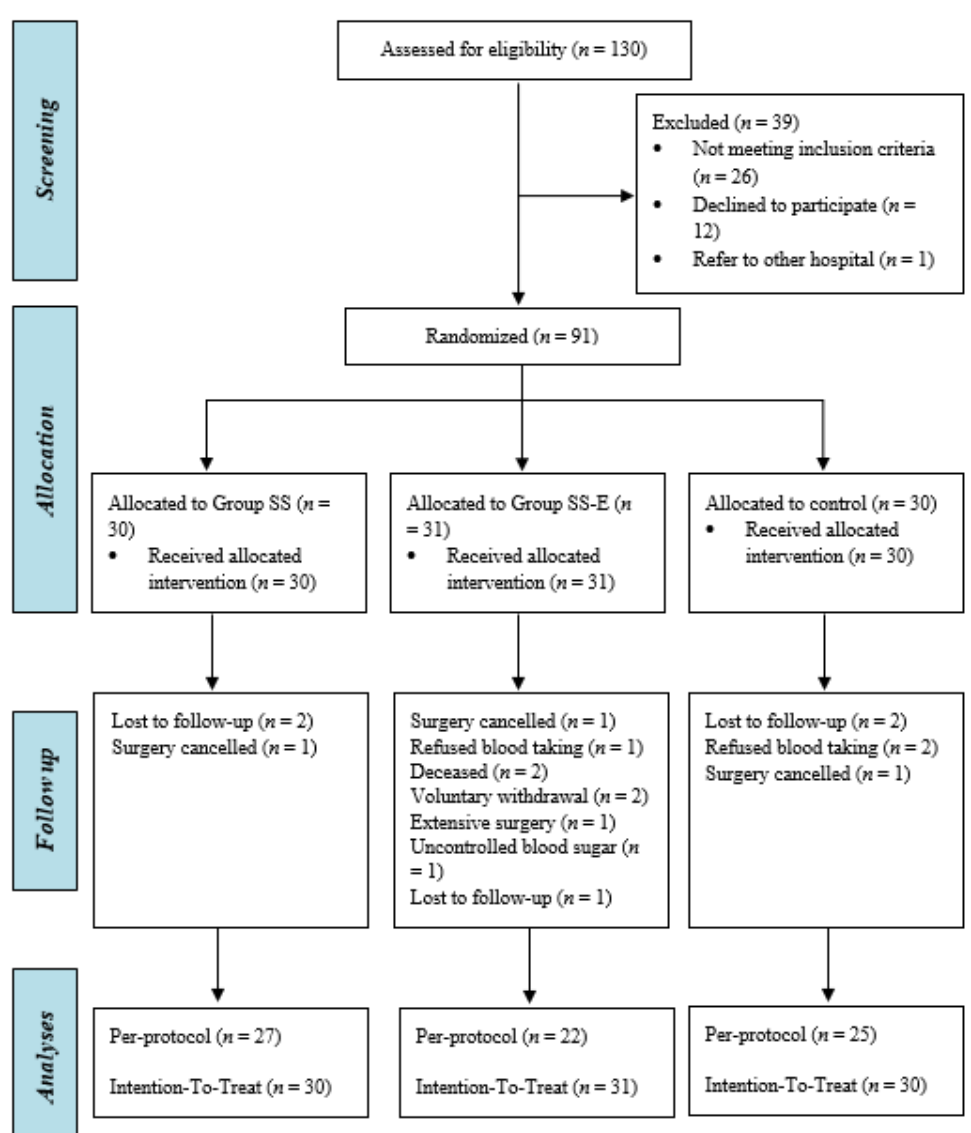
Figure 1. CONSORT flow diagram.